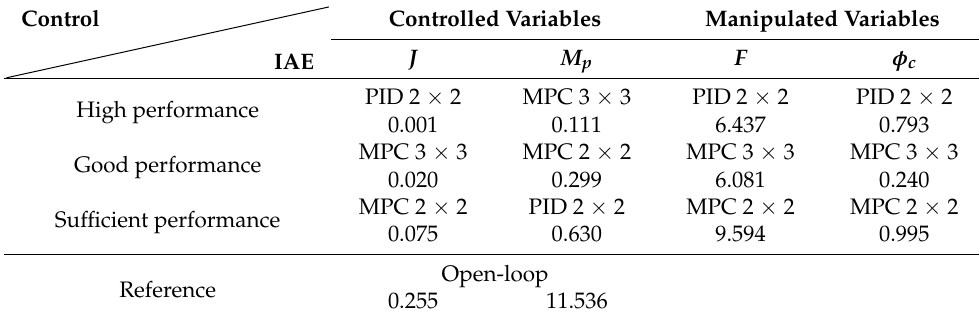
Figure 7. Dynamic responses of controlled variables: ( a ) SAG mill load (J); ( b ) power consumption ( M p ) and manipulated variables; ( c ) feed ( F ); ( d ) percentage of critical speed ( ϕ c ). Table 1. Analysis and interpretation of results obtained by controllers, SAG